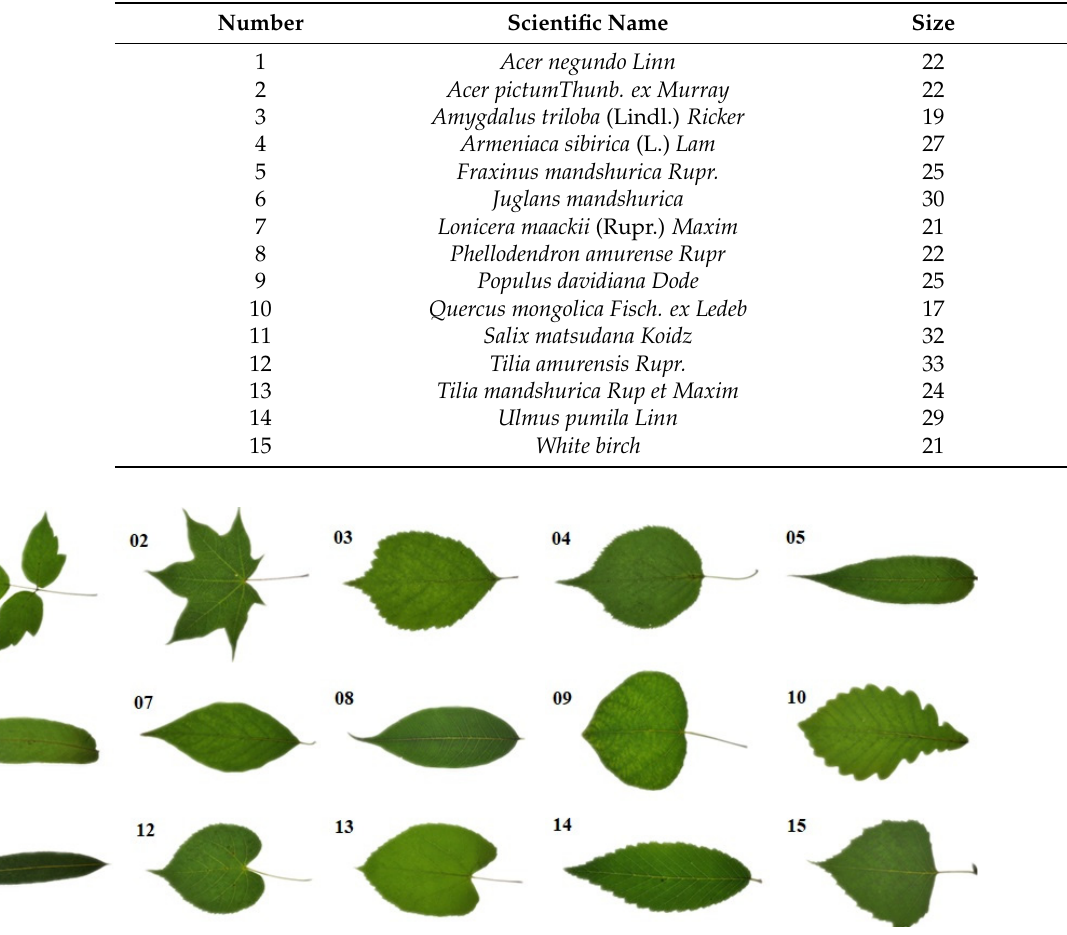
Figure 2. Leaf images used for classification, one sample for each type, with the number corresponding to the number in Table 1.